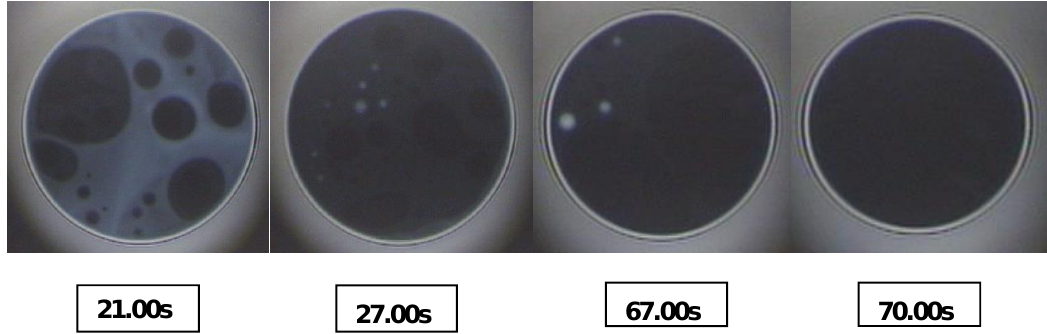
Figure 8. Evaluation of drainage of foam film stabilized for total surfactant concentration 4 × 10 −5 mol/L of the CTAC:C 12 E 5 = 1:1 mixture.